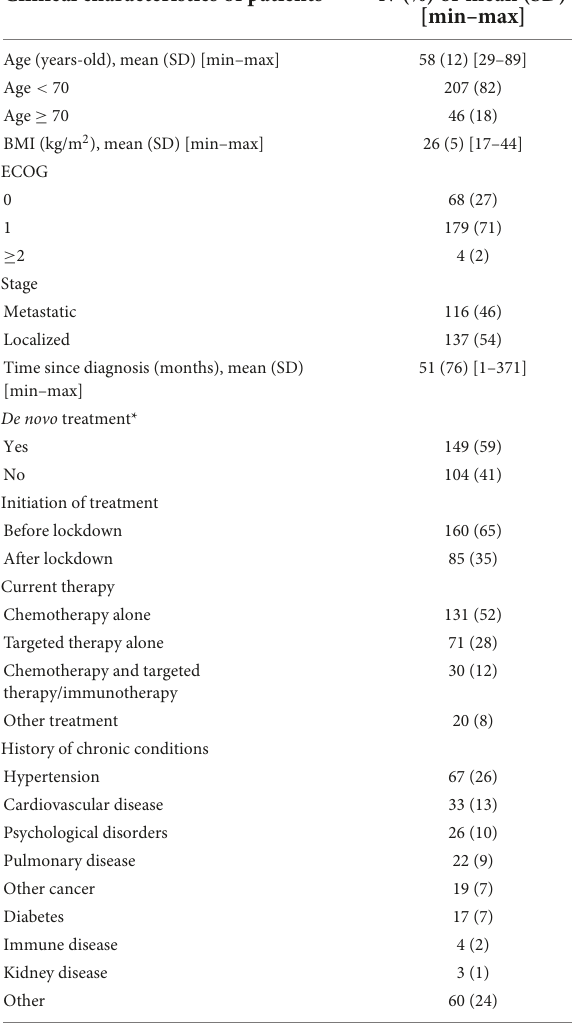
TABLE 1 Clinical characteristics of breast cancer (BC) patients ( N =